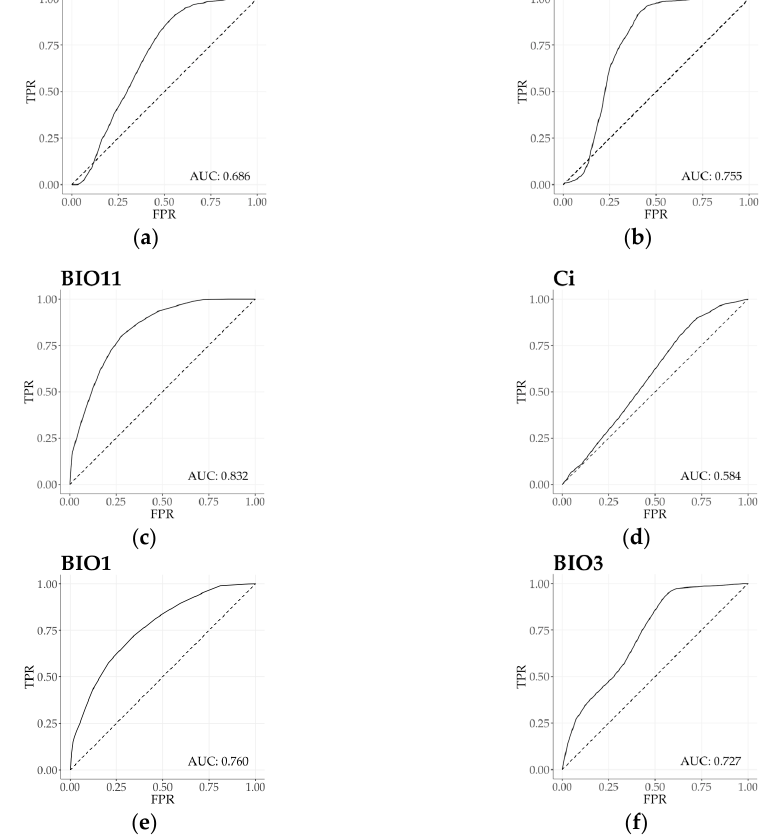
Figure 4. ( a – f ) ROC curves with AUC estimation (Receiving Operating Characteristic curve with Area Under the Curve) of beech forests for selected variables corresponding with climatic traits in Figure 3. ( a ) Precipitation seasonality (BIO15); ( b ) Annual precipitation (BIO12); ( c ) Mean temperature of the coldest quarter (BIO11); ( d ) Continentality (Ci); ( e ) Annual mean temperature (BIO1); ( f ) Isothermality (BIO3). Solid line indicates beech forests function and dashed line indicates random area value of the geographic region as the reference (AUC = 0.5). FRP = False Positive Rate, TRP = True Positive Rate. For ROC curves and AUC values of additional variables see Figure S2.